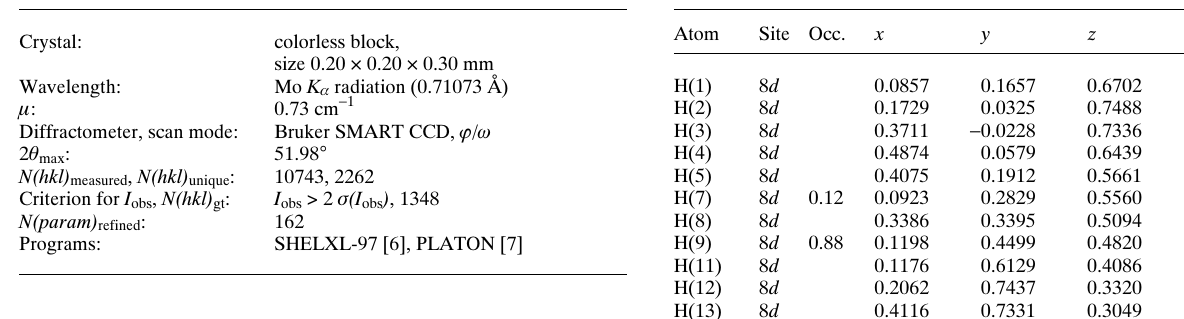
Table 2. Atomic coordinates and displacement parameters (in Å 2 ) . Table 1. Data collection and